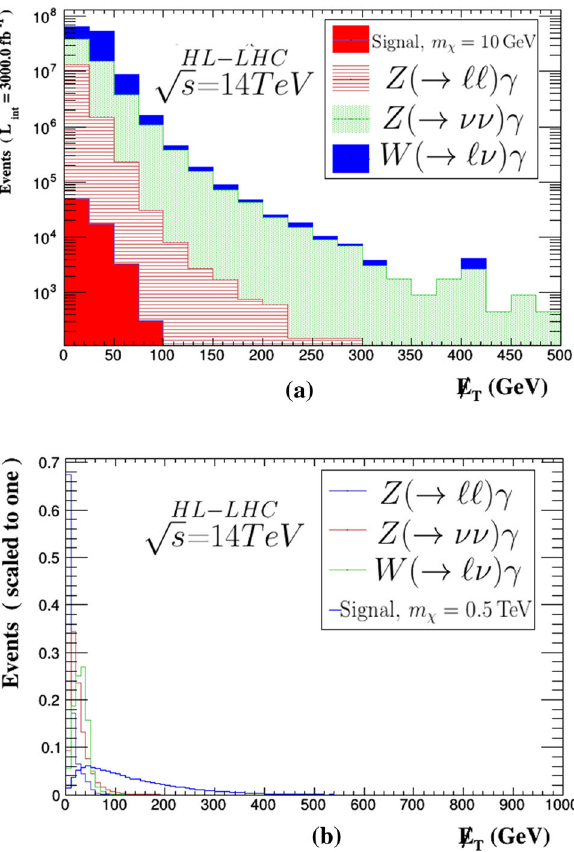
Fig. 10 Distribution of E miss with no cuts for signal and main back- T ground processes. a m χ = 10GeV; b m χ = 0 . 5TeV and normalized to